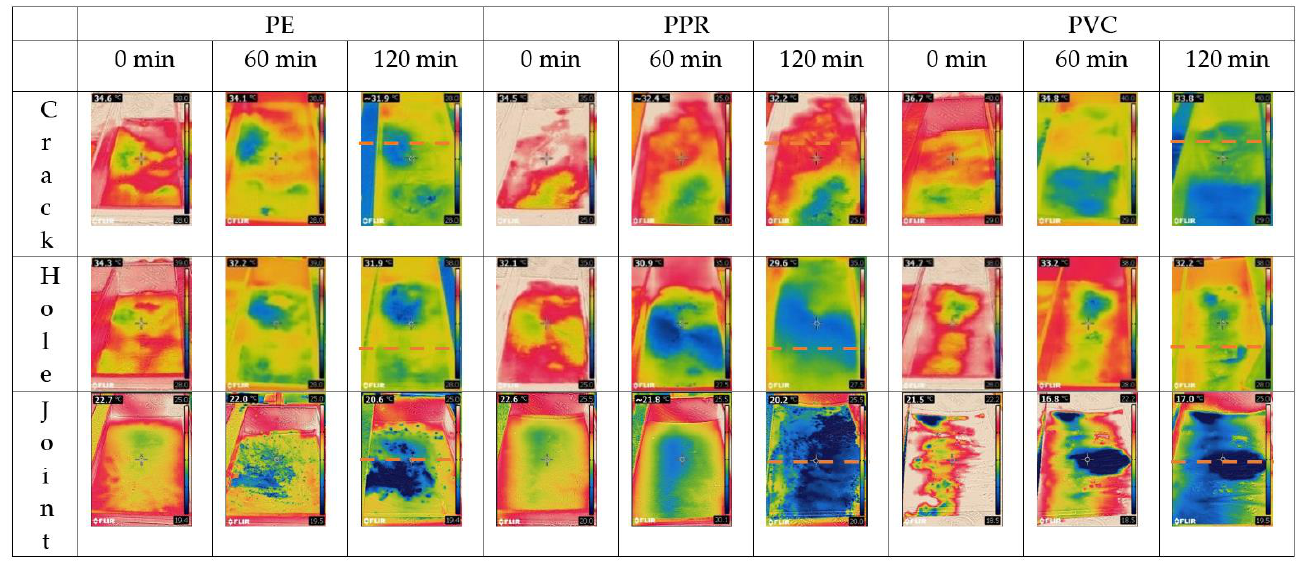
Figure 12. IR images obtained on PPR, PVC and PE setup with 2% soil moisture content.